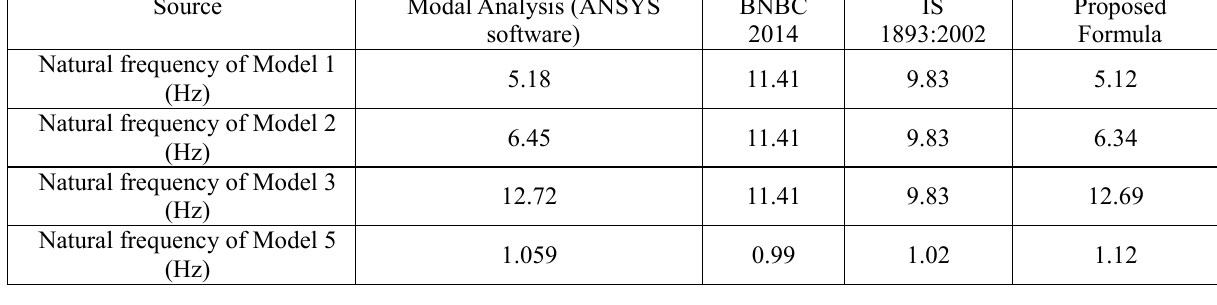
Table 2 Natural Frequency of Models obtained from different Formula from Previous Study. Source Modal Analysis (ANSYS